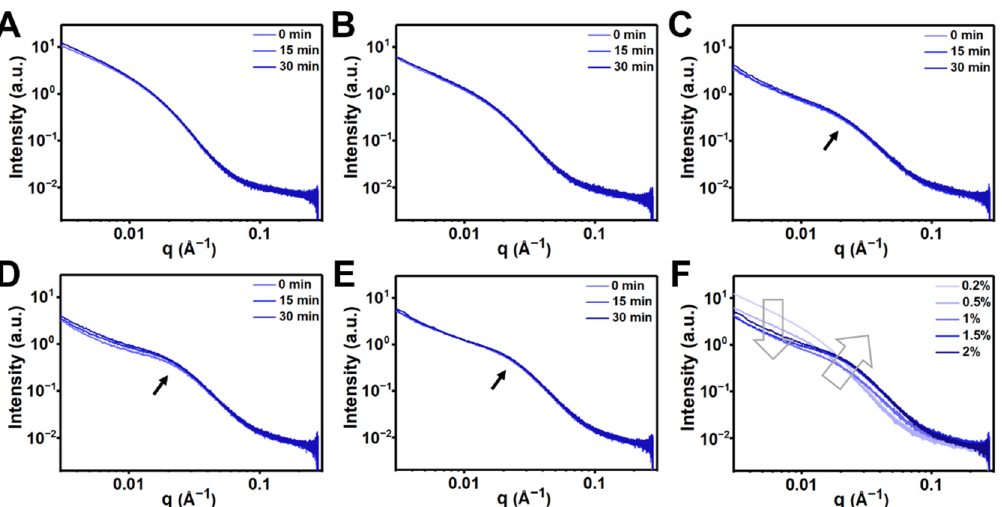
Figure 4. Coherent SAXS profiles for CC hydrogels with different solid contents at 25 °C in different scales of setting time (0, 15, and 30 min). The solid contents of CC hydrogels were ( A ) 0.2%, ( B ) 0.5%, ( C ) 1%, ( D ) 1.5%, and ( E ) 2%. ( F ) Comparison of the scattering profiles among CC hydrogels with different solid contents (data obtained at 30 min).